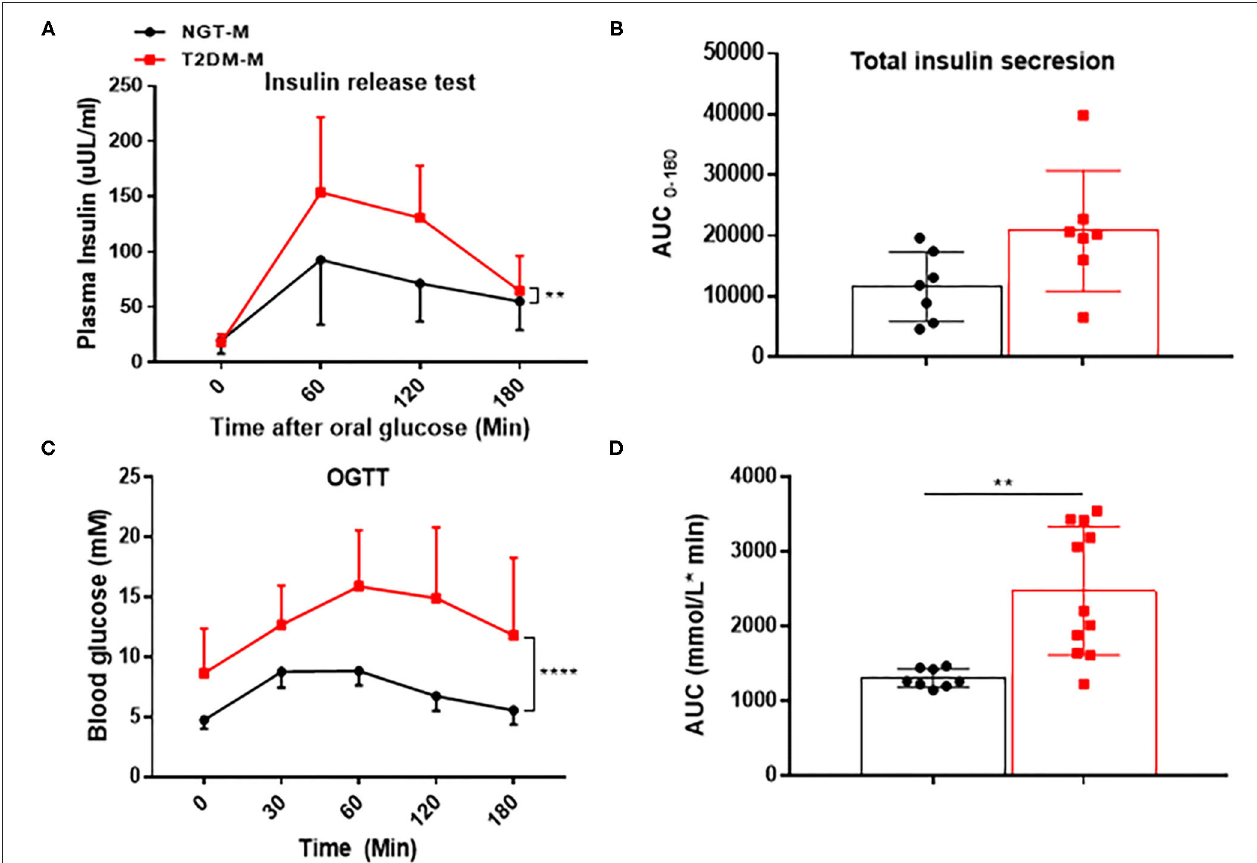
FIGURE 1 | The indicators of insulin resistance in MAFLD patients. (A,B) Insulin release test and the respective analysis of the area under the curve (AUC) ( n = 7). (C,D) Oral glucose tolerance test (OGTT) and the respective analysis of the area under the curve (AUC) ( n = 8–11). The data are expressed as the mean ± SD, ** P < 0.01, **** P <